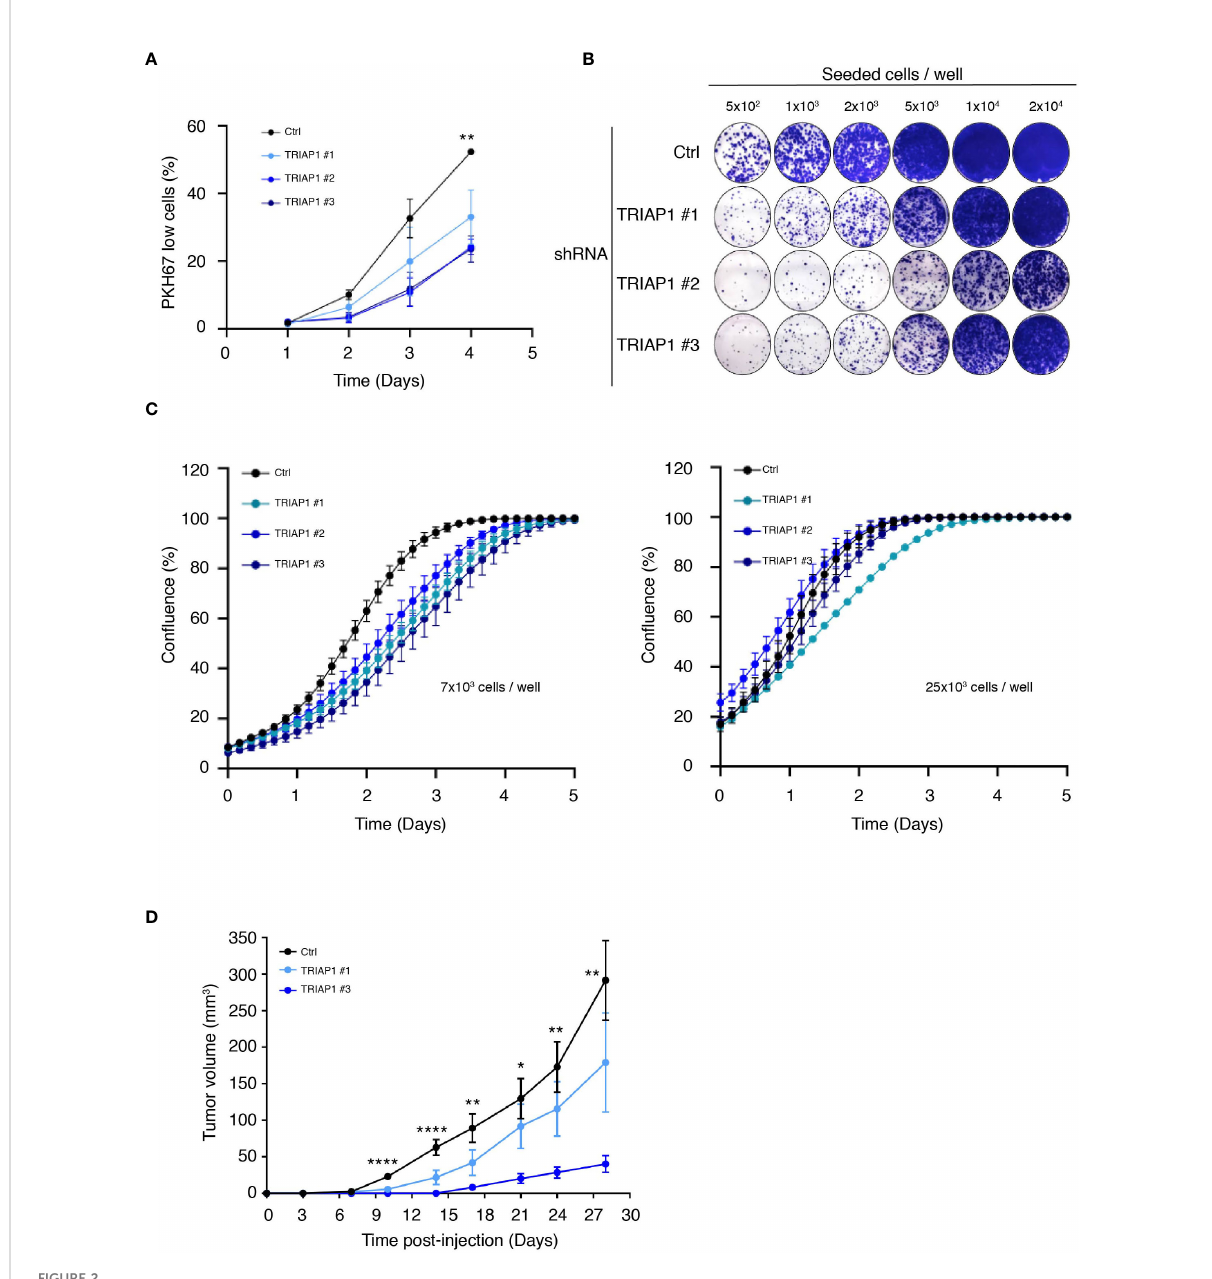
FIGURE 2 TRIAP1 depletion impairs HCT116 cancer cell proliferation and tumorigenesis. (A) Proliferation rate of HCT116 cells transduced with lentiviral control (Ctrl) and TRIAP1 (TRIAP1 #1, #2, and #3) shRNAs was monitored using fl ow cytometry and the vital lipophilic fl uorescent dye PKH67 (similar to 1C), which is lost upon cell proliferation. On the indicated day, triplicate samples of PKH67-labeled HCT116 cells were analyzed and the % of “ PKH67 Low ” population was calculated compared with day 0. Data are represented as mean ± SEM of triplicate. (B) Representative images of colony-forming assay for HCT116 cells transduced with lentiviral control (Ctrl) or TRIAP1 (TRIAP1 #1, #2, and #3) shRNAs. Cells were seeded at the indicated densities, and 11 days post plating, colonies were stained with crystal violet. Note the amelioration of the colony-forming capacity of TRIAP1 knocked down cells at higher cell density. (C) Effect of TRIAP1 depletion on cell proliferation. HCT116 cells transduced with lentiviral control (Ctrl) or TRIAP1 (TRIAP1 #1, #2, #3) shRNAs were seeded in 48-well plates (7 × 10 3 cells/well; left panel or 25 × 10 3 cells/panel; right panel). Cell proliferation was monitored in real time, for the indicated number of days, using the label-free Incucyte Live-Cell Analysis system. Changes in cell con fl uence are used as an indicator of cell proliferation. Data are represented as the mean ± SD. Note the amelioration of the proliferative capacity of TRIAP1 knocked-down cells at higher cell density. (D) Growth curves of HCT116 tumors developed as xenografts in athymic mice. Nude mice were subcutaneously injected with 5 × 10 6 HCT116 cells transduced with the control (Ctrl) or TRIAP1 (TRIAP1 #1 and #3) shRNAs. On the indicated days post injection, tumor volumes were determined as described in the Material and Methods section. Data are represented as the mean ± SEM. For statistical comparison, ANOVA tests were performed, *p < 0.05; **p < 0.01; ****p <